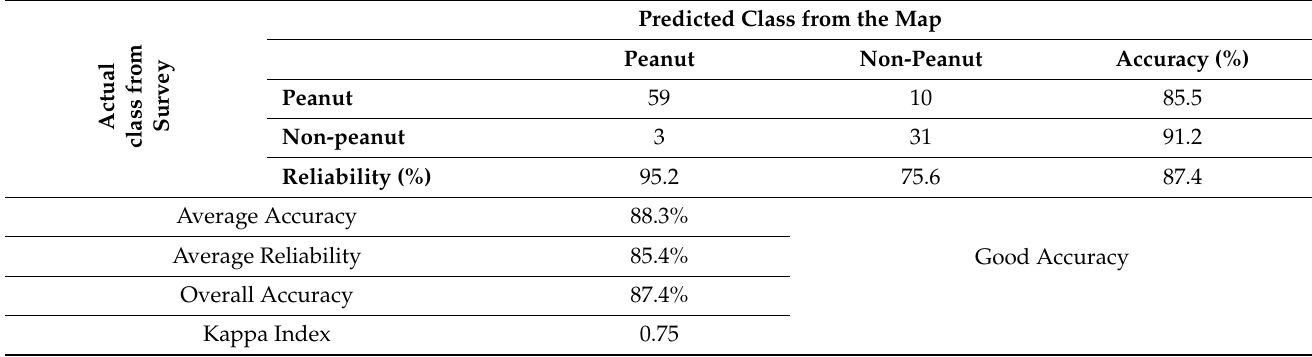
Table 2. Confusion matrix for accuracy assessment for peanut classification during Rabi